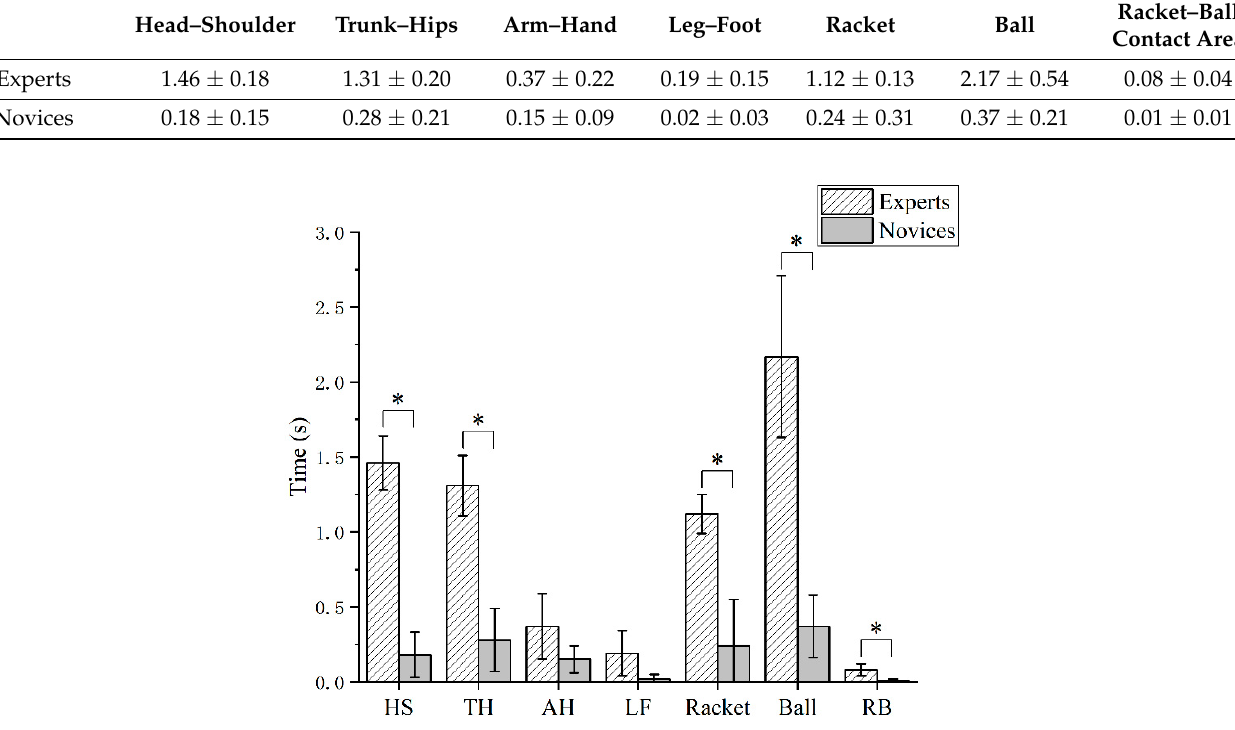
Figure 4. Gaze time for different positions during a backhand shot for different skill level tennis players. HS: head–shoulder, TH: trunk–hips, AH: arm–hand, LF: leg–foot; RB: racket–ball. *: Statistically significant difference between experts and novices.